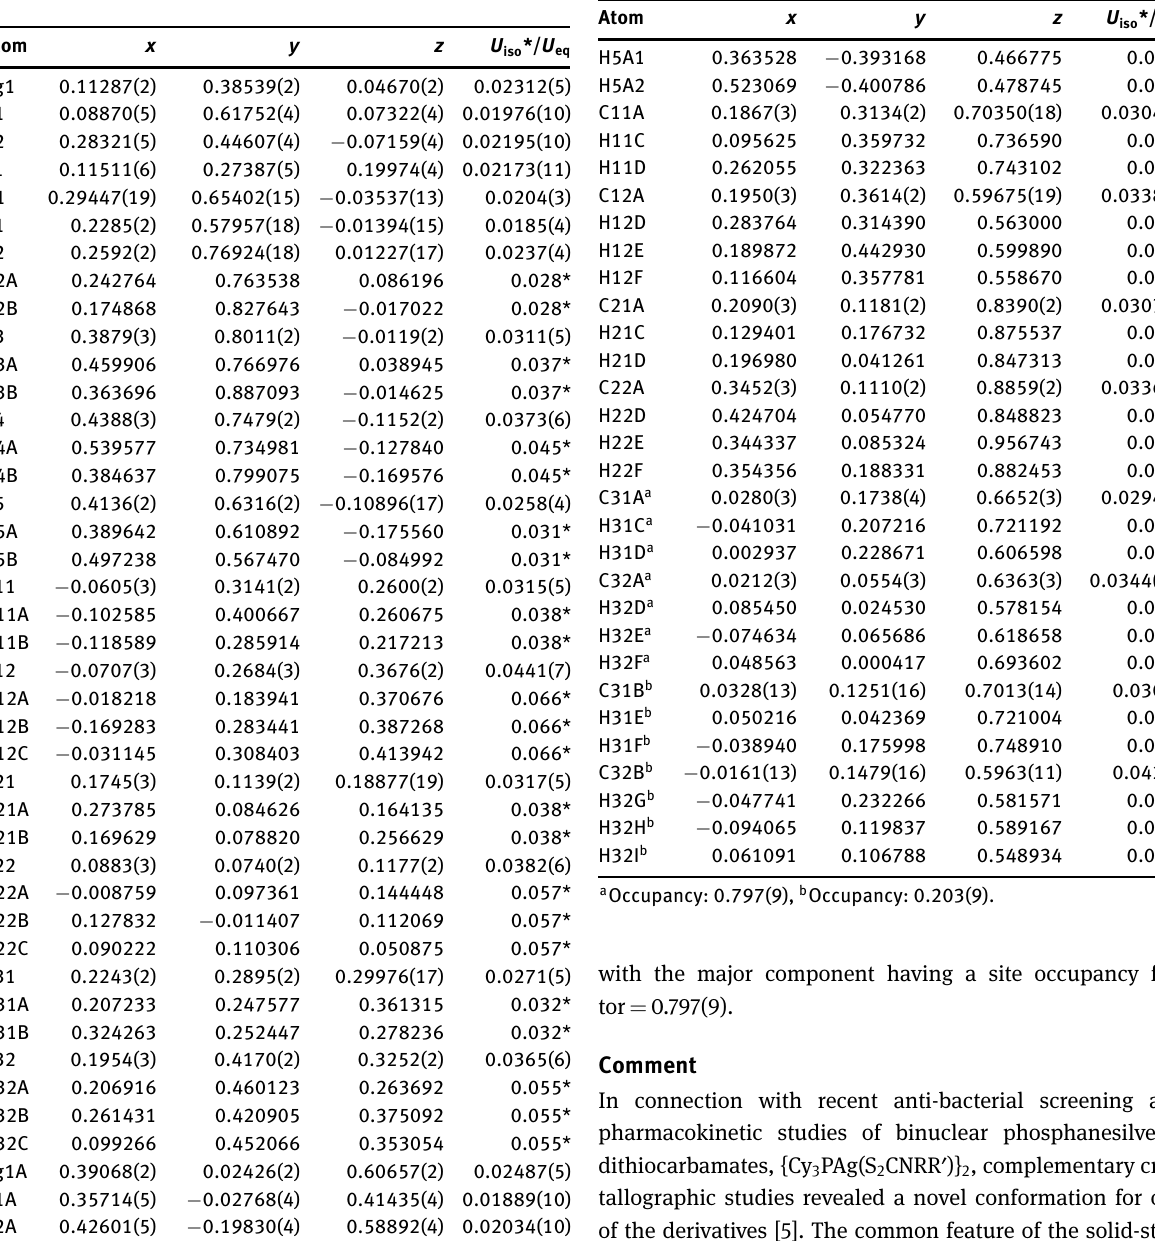
Table 2: Fractional atomic coordinates and isotropic or equivalent isotropic displacement parameters (Å 2